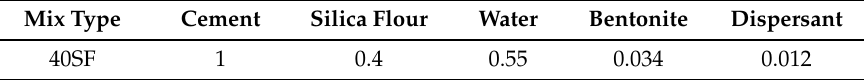
Table 1. Mixture design of G-class cement slurry (by mass).